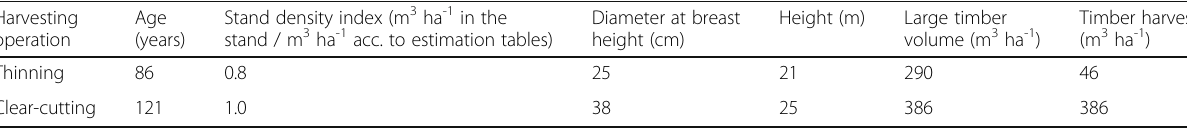
Table 1 Selected features of the investigated stands Harvesting operation